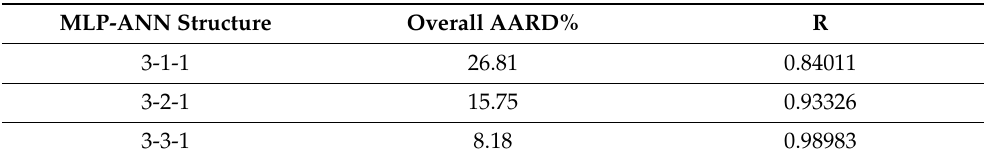
Table 3. Sensitivity analysis on the topology of